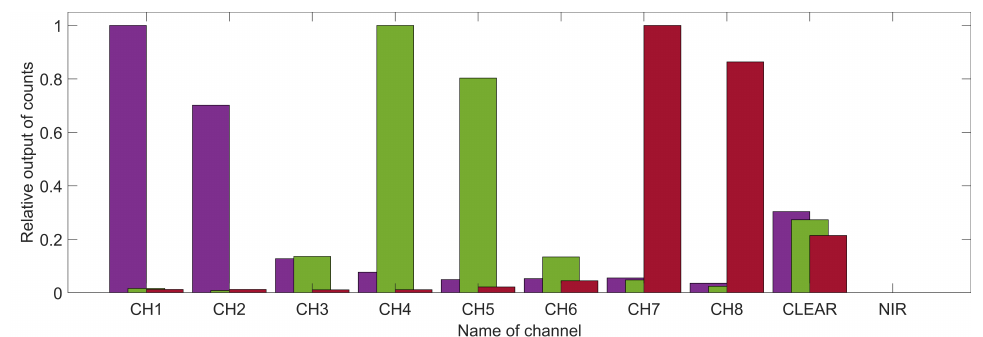
Figure 4. Three example data sets measured with the AS7341 in the insulator box. In each set, either a narrow-bandwidth LED with violet (425nm), green (530nm), or red (629nm) emission (in the figure shown from left to right) is turned on. As expected, channels corresponding to the LED spectrum show a high signal. The AS7341’s clear channel shows an output for every LED due to its broadband sensitivity. The near infrared (NIR) channel, sensitive in the near infrared, shows as expected negligible output.